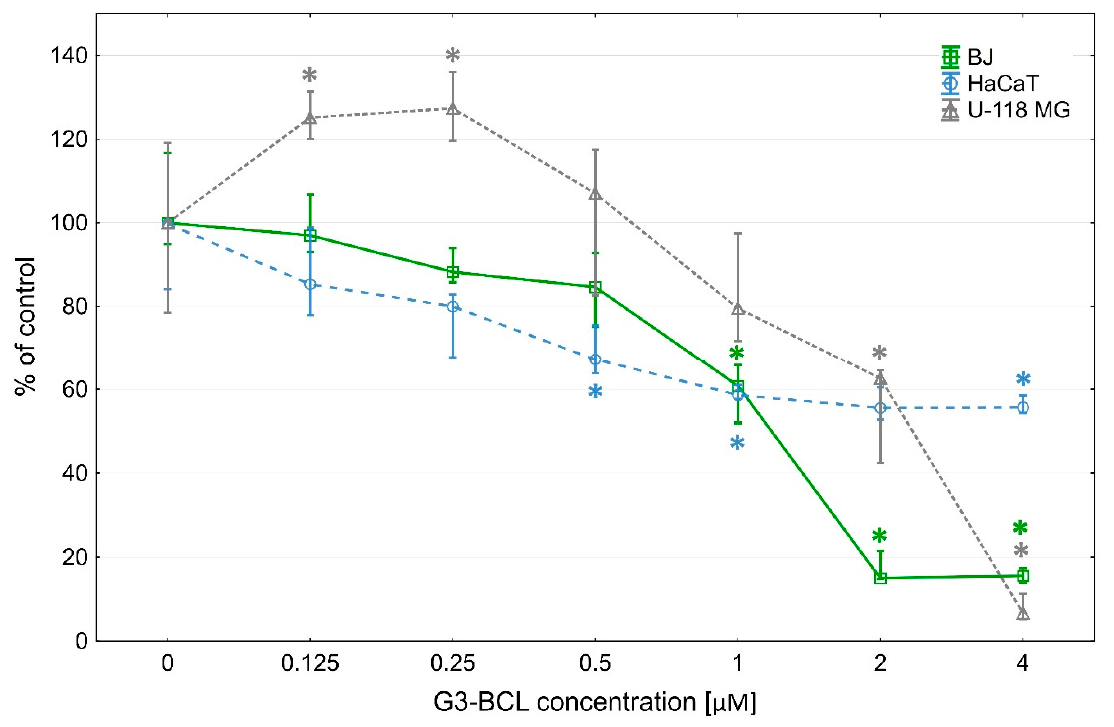
Figure 2. Proliferation of investigated cells after 72 h incubation with G3-BCL conjugate. Results are presented as median of triplicate from three independent experiments and expressed as % of non-treated controls. The whiskers are lower (25%) and upper (75%) quartile ranges. * P < 0.05; Kruskal–Wallis test.